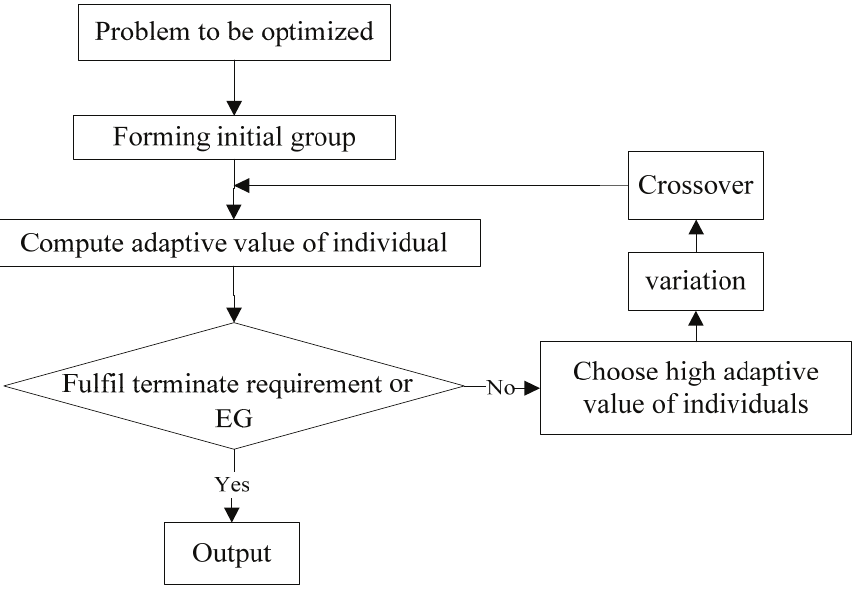
Figure 4. Flow Diagram of the Differential Evolution